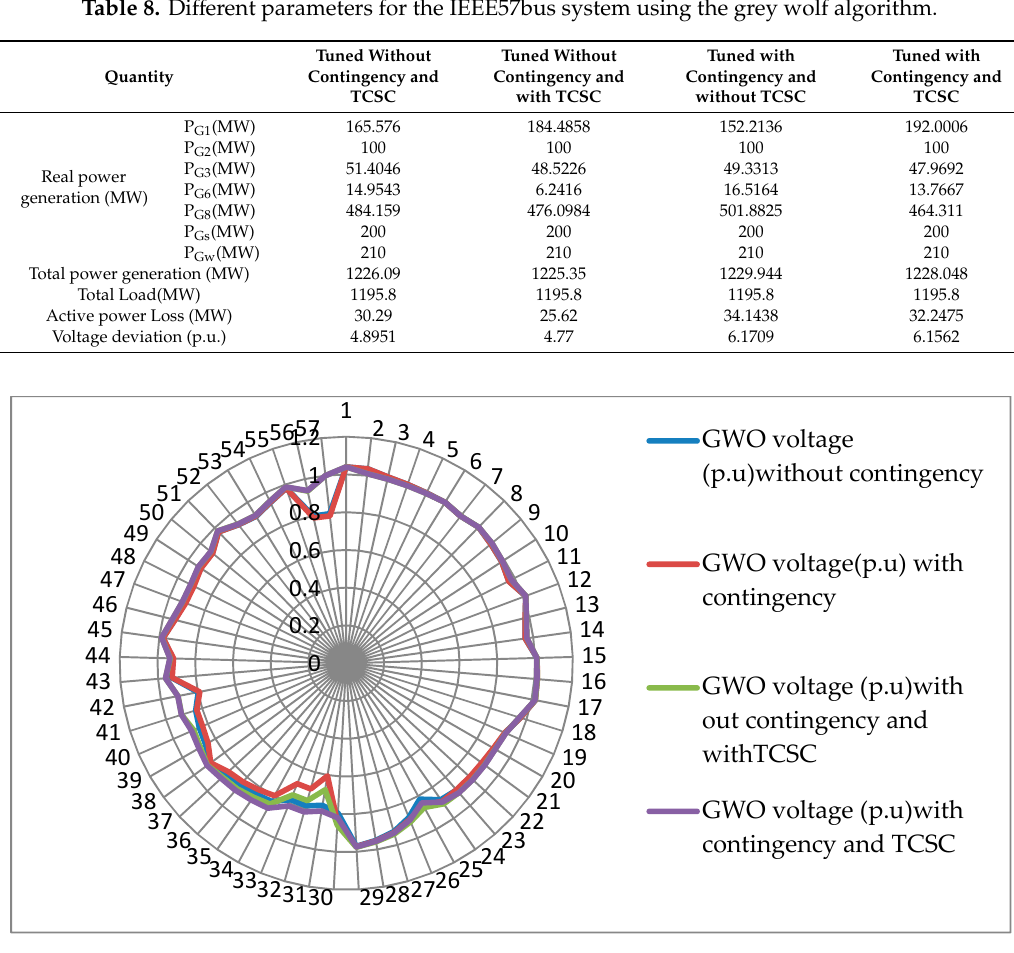
Figure 8. Voltage profile for the IEEE 57 bus system including and excluding TCSC. Table 9. Optimal power flow solution with contingency using GWO.